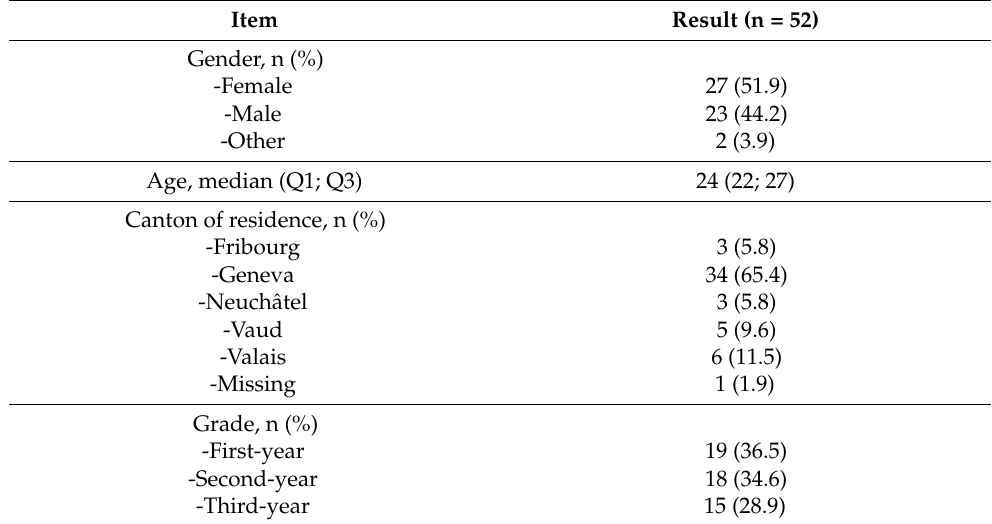
Table 3. Characteristics of students who answered the GHQ-12. Item Result (n =